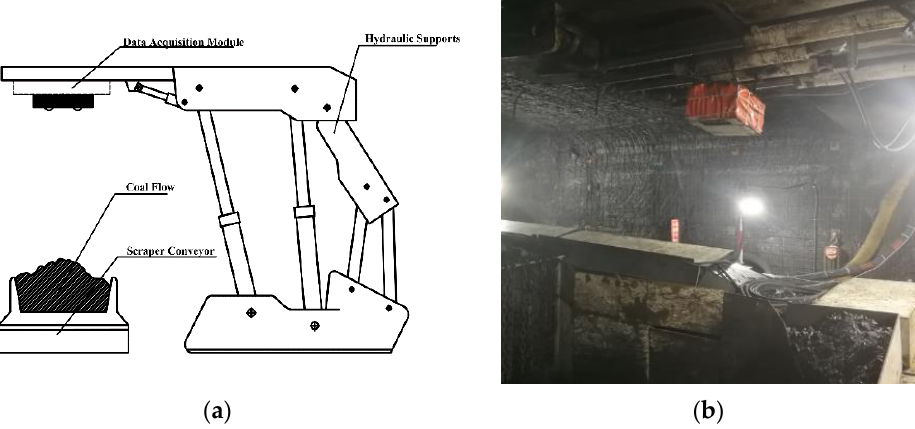
Figure 10. Equipment installation diagram: ( a ) Equipment installation diagram; ( b ) Field equip- ment.